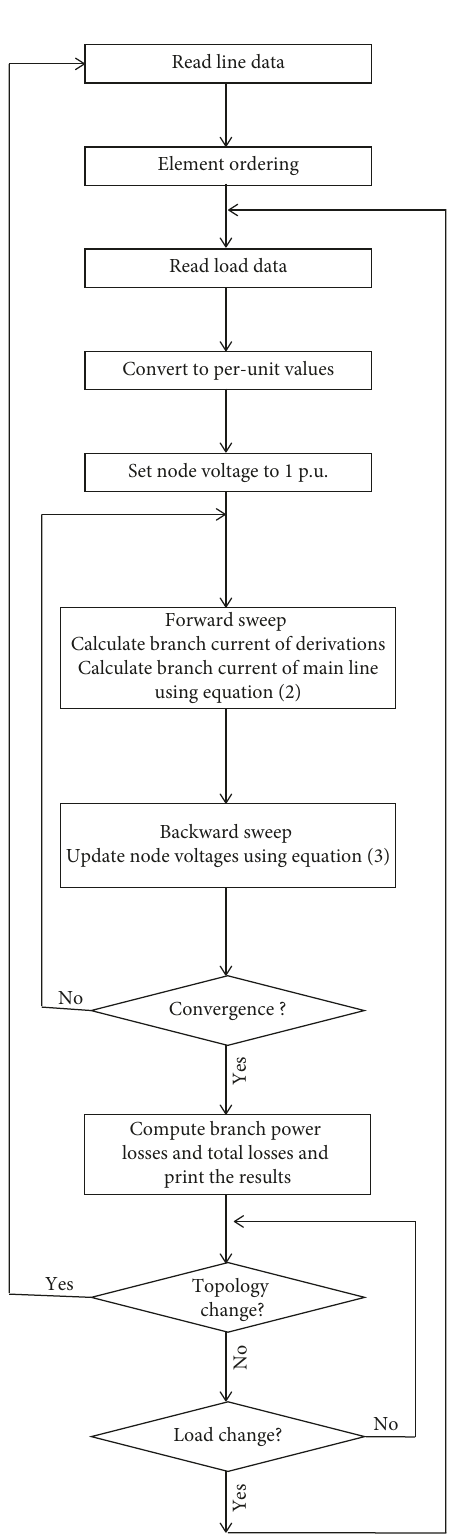
Figure 5: Flow chart of the proposed method.